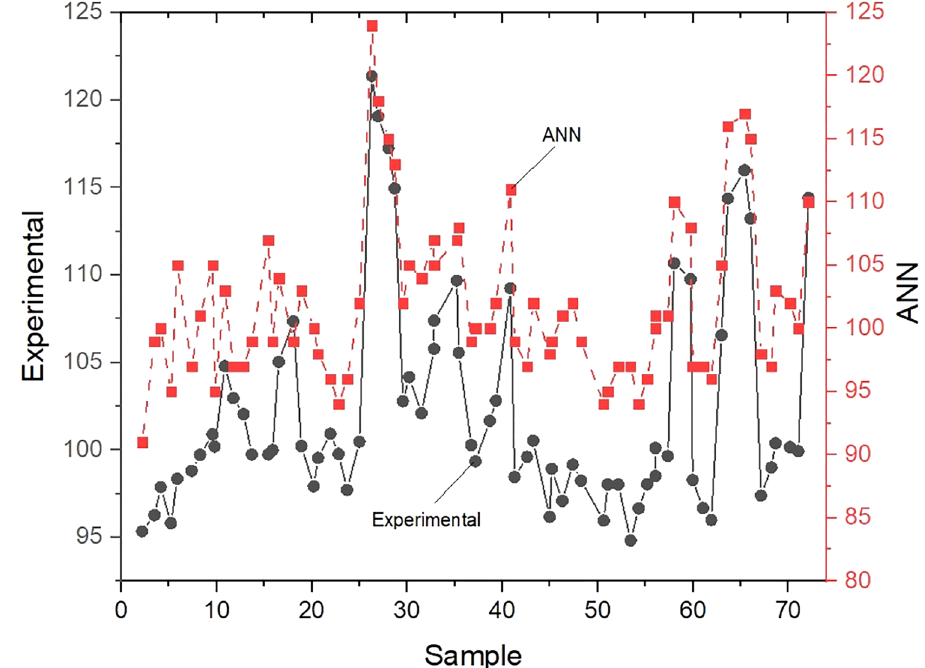
Fig. 7 Comparison between the neural network data and the real data in the hardness